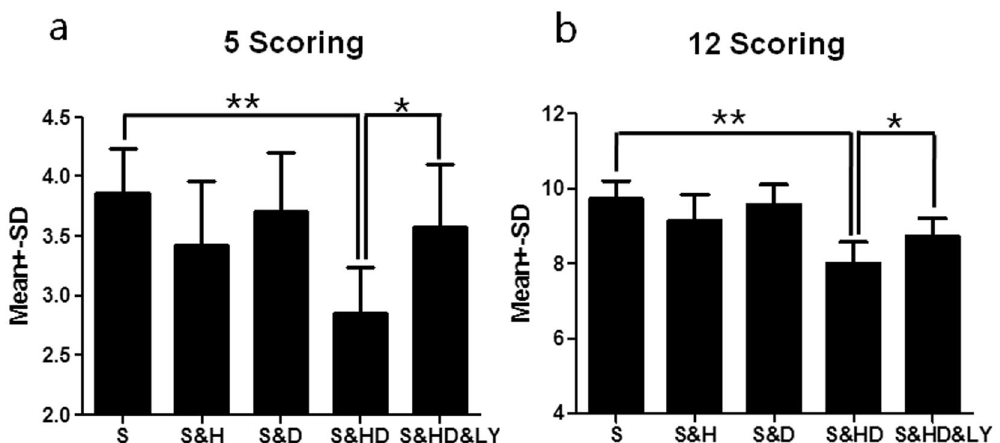
Figure 3. Neurological deficit (n = 7 per group) after combination therapy of mild hypothermia and C + P, using the 5-score system ( a ) and 12-score system ( b ). ANOVA analyses indicated that combination therapy (S&HD) significantly ( ** P < 0.01) reduced neurological deficits. Monotherapy with either mild hypothermia (S&H) or C + P (S&D) alone did not significantly improve outcomes in neuroprotection. Treatment with p-Akt inhibitor (LY294002) (S&HD&LY) reversed the combination therapy’s effect in neurological improvement ( * P <